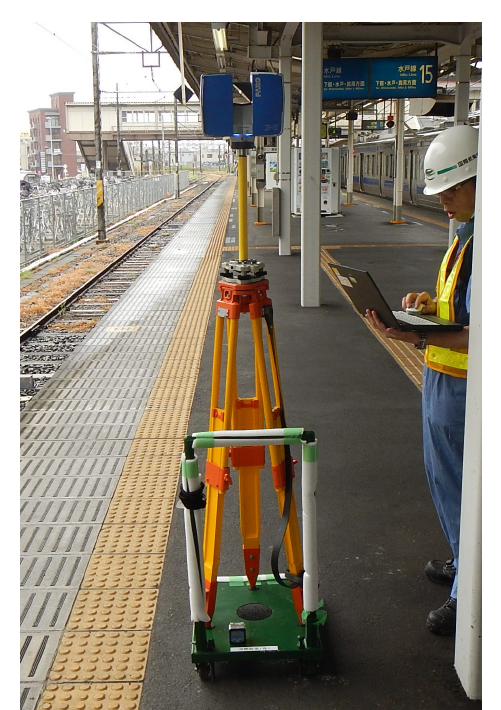
Figure 4. Prototype of our new